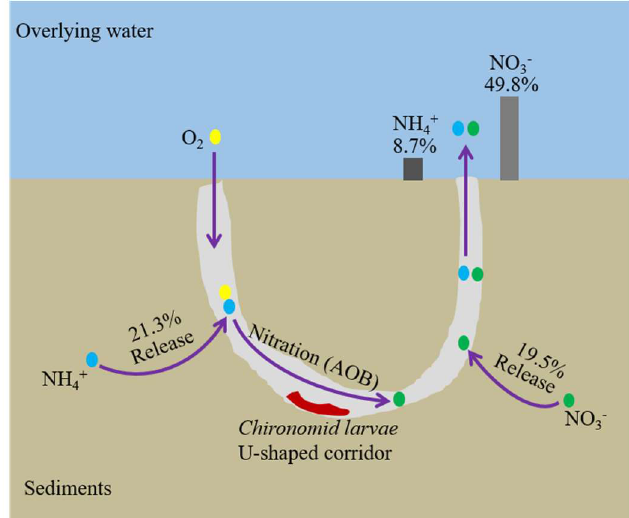
Figure 7. Schematic illustration of the processes of Chironomid larvae bioturbation impact on N release and conversion at the SWI.